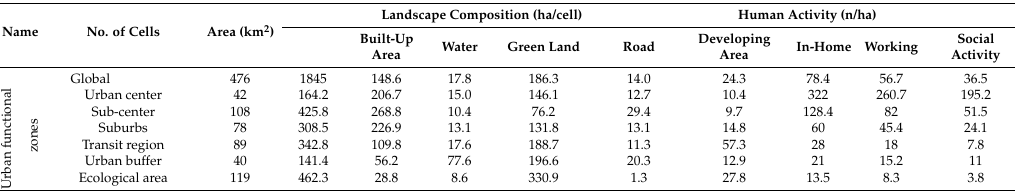
Table 3. Composition of landscape and human